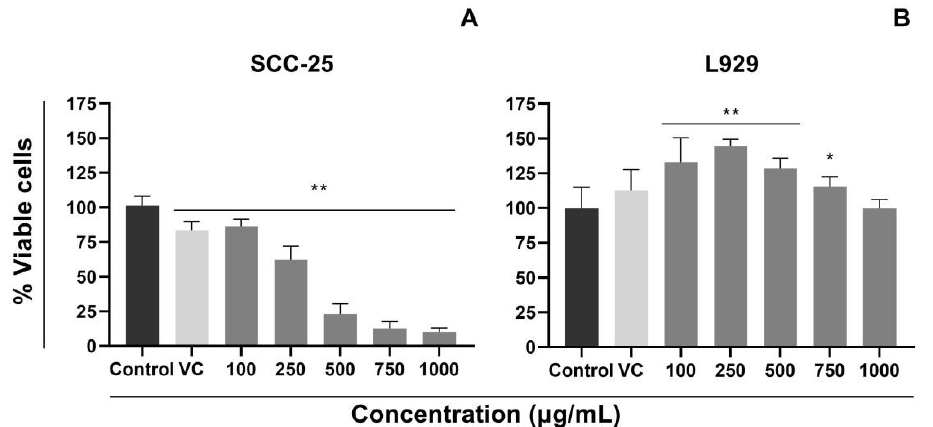
Figure 7. Cytotoxic effect of VADE-loaded-hydrogel on SCC-25 ( A ) and L929 ( B ) cell lines, after 24 h of treatment. Data were reported as mean ± SD of at least three independent experiments, done in quintuplicate. * p < 0.05; and ** p < 0.001, measured by analysis of variance (ANOVA), followed by Tukey post-test. VADE = Viscum album dry extract; Control = cells in culture medium (without treatment); VC = vector control (hydrogel without VADE).